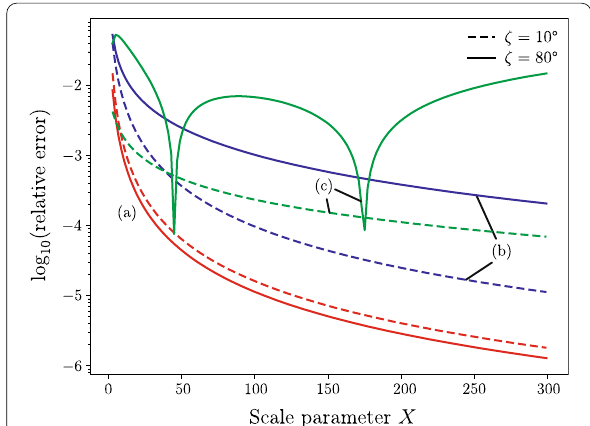
Fig. 3 Relative error as a function of the scale parameter for small (dashed) and large (solid) solar zenith angles. Three analytical formulas are compared: a is Eq. (36) obtained in this work, b is the Kocifaj formula (Kocifaj 1996) that shows the best performance among analytical approximations found in the literature, and c is the empirical formula of Green and Barnum (1963); Green et al.